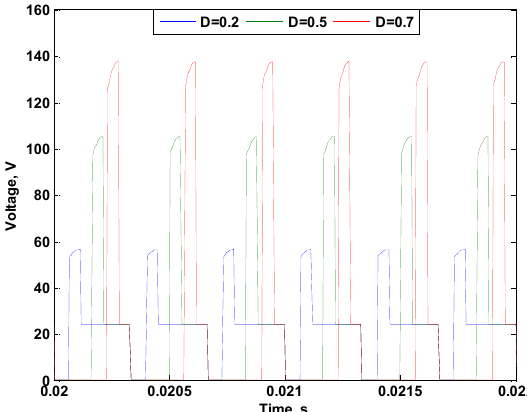
Figure 11. Voltage stress across the second-stage switch.